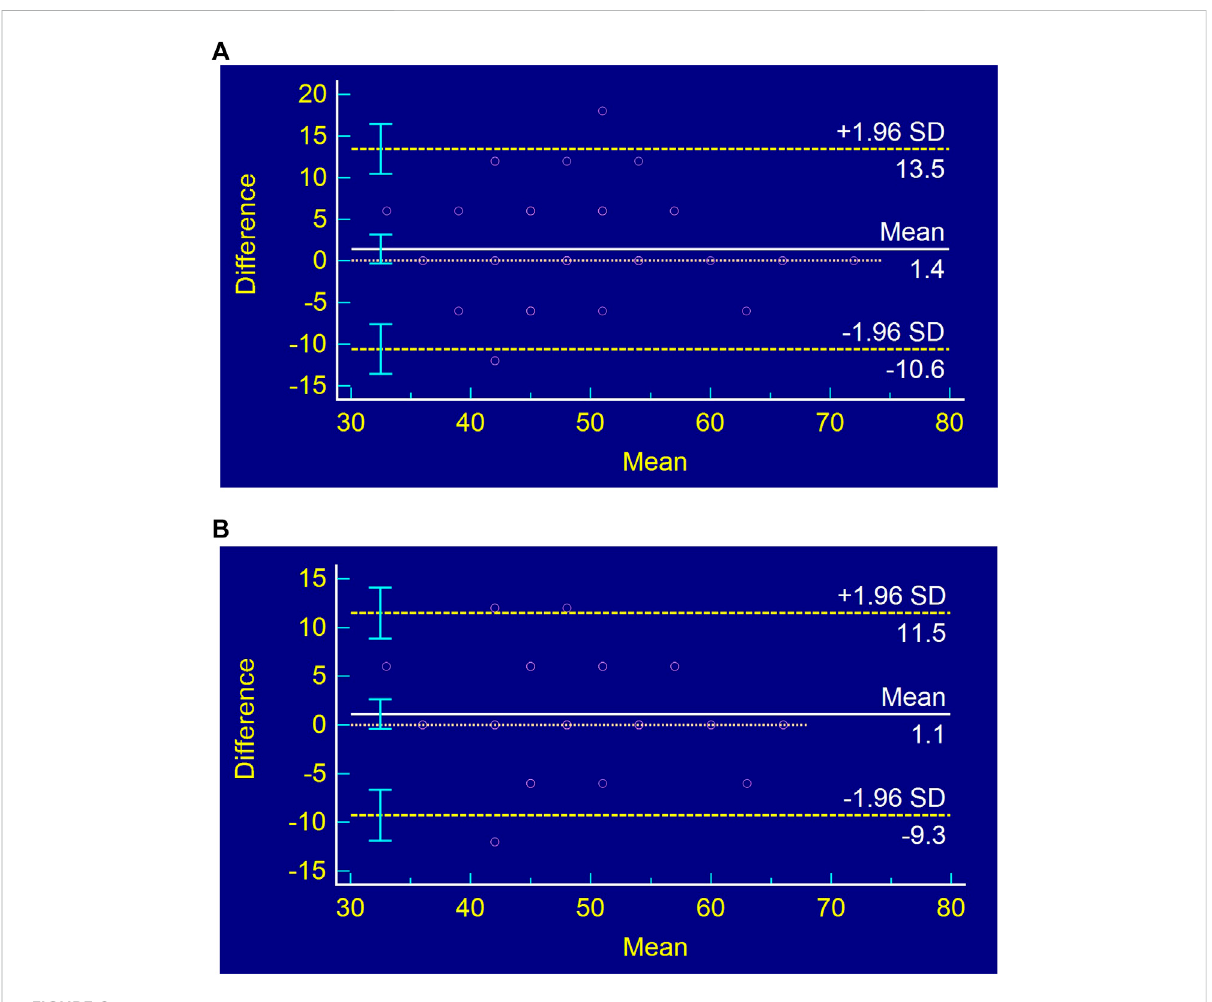
FIGURE 8 Bland-Altman plot. (A) Bland-Altman plot of RR-D. (B) Bland-Altman plot of